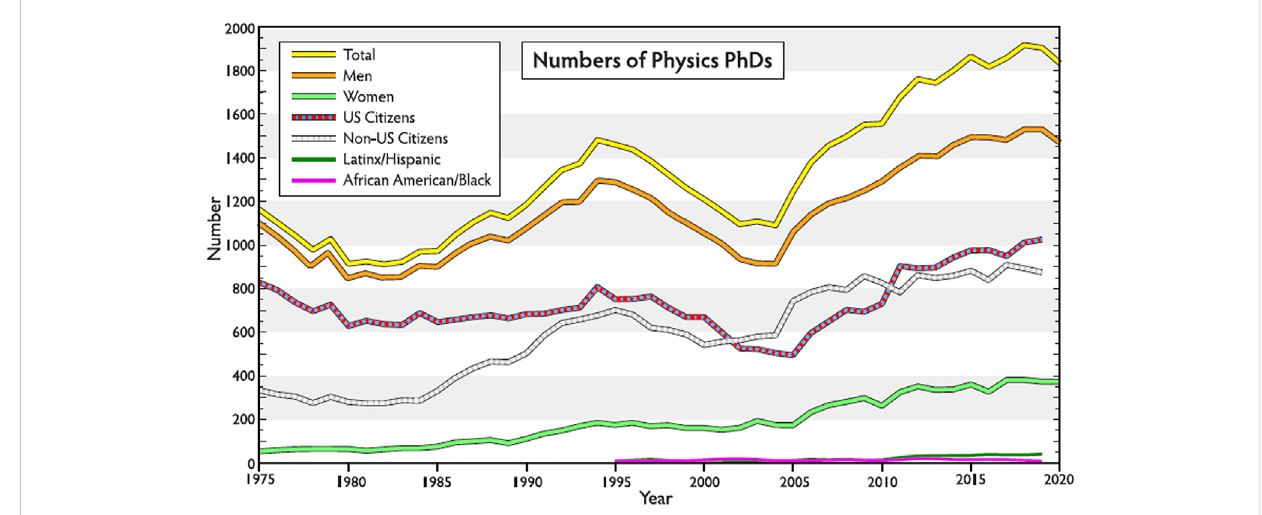
FIGURE 7 Trends in Physics disaggregated by gender and citizenshipstatus as well as race/ethnicity.Produced using data from theStatisticalResearch Center of the American Institute of Physics, see